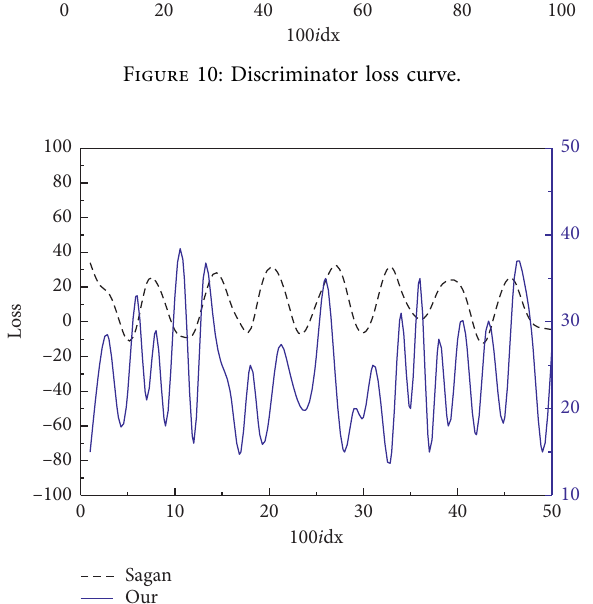
Figure 11: Generator loss curve.